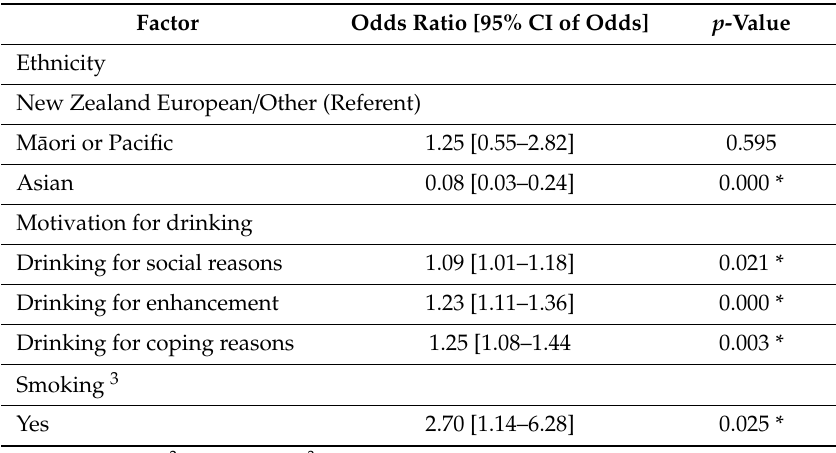
Table 6. Factors associated with risky drinking among sexually active nonpregnant women who consumed alcohol 1,2